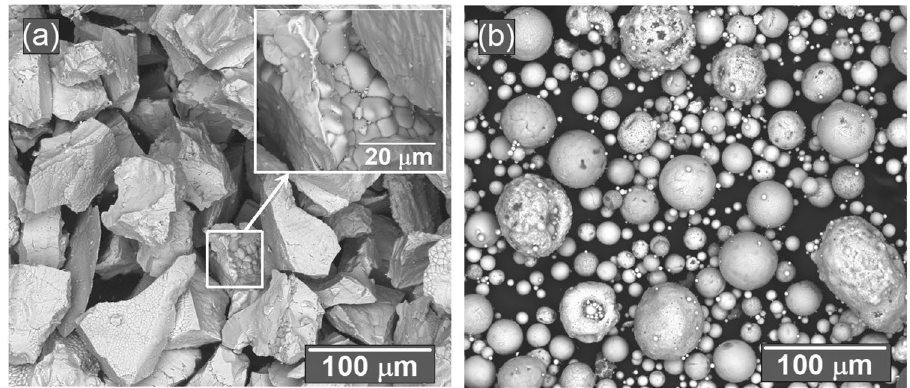
Figure 7. SEM images showing morphology of the as-received CSZ and MSZ feedstock powders in ( a ) and ( b ), respectively. The in situ in ( a ) is a high magnification SEM image of CSZ granulated particle showing micrograins feature.